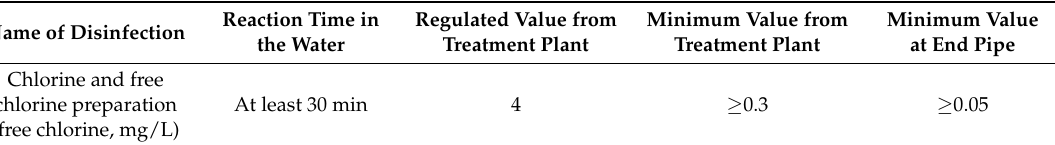
Table 16. Conventional index of sanitiser and the requirements in drinking water.